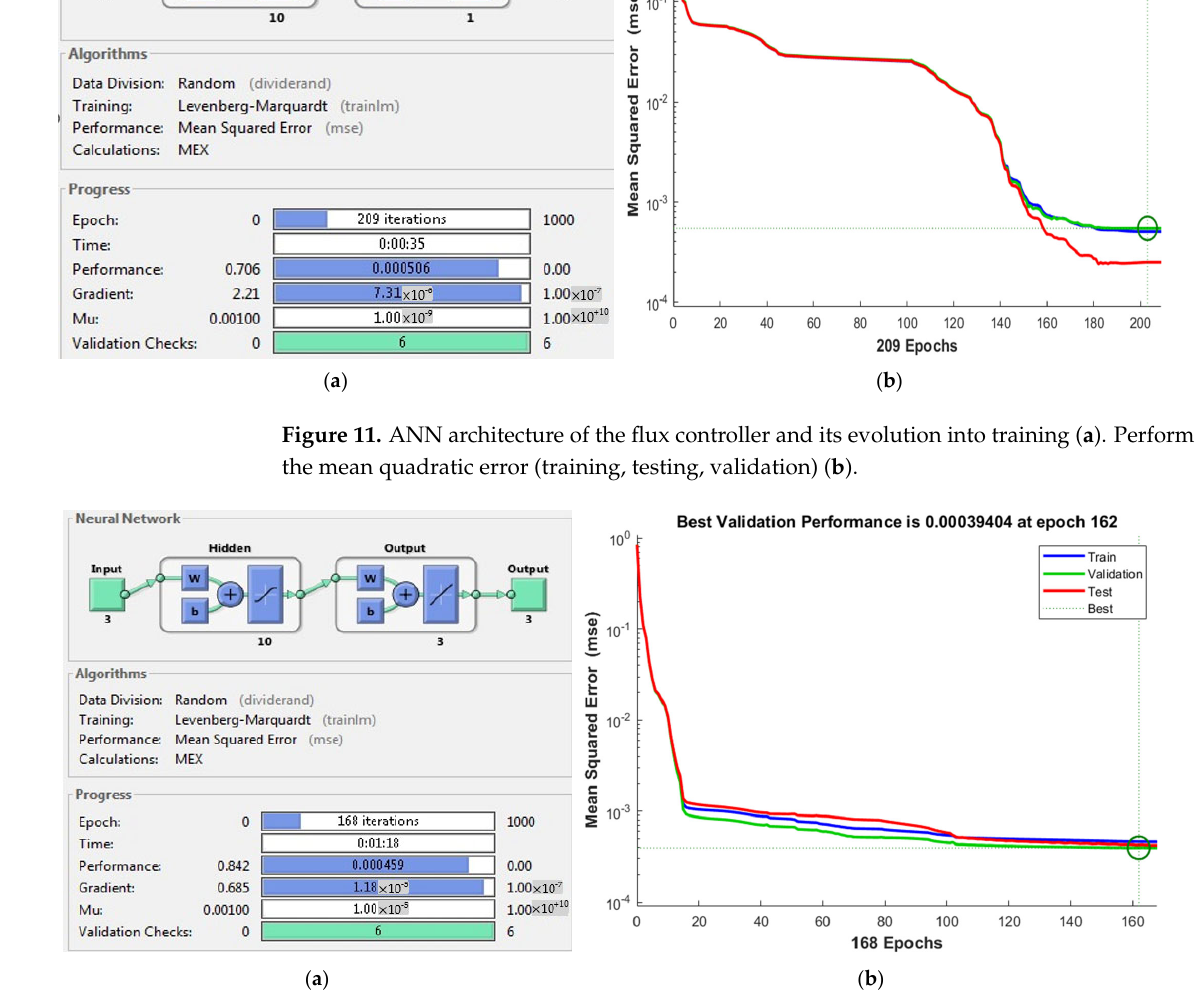
Figure 12. ANN architecture of the switchboard controller and its evolution formation ( a ). Perfor- mance of the mean quadratic error (training, testing, validation) ( b ). Table 2. Specification of the optimum proposed ANN models, values and